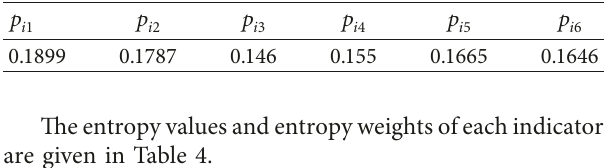
Table 3: Share of each indicator in the sum of all indicators. p i 1